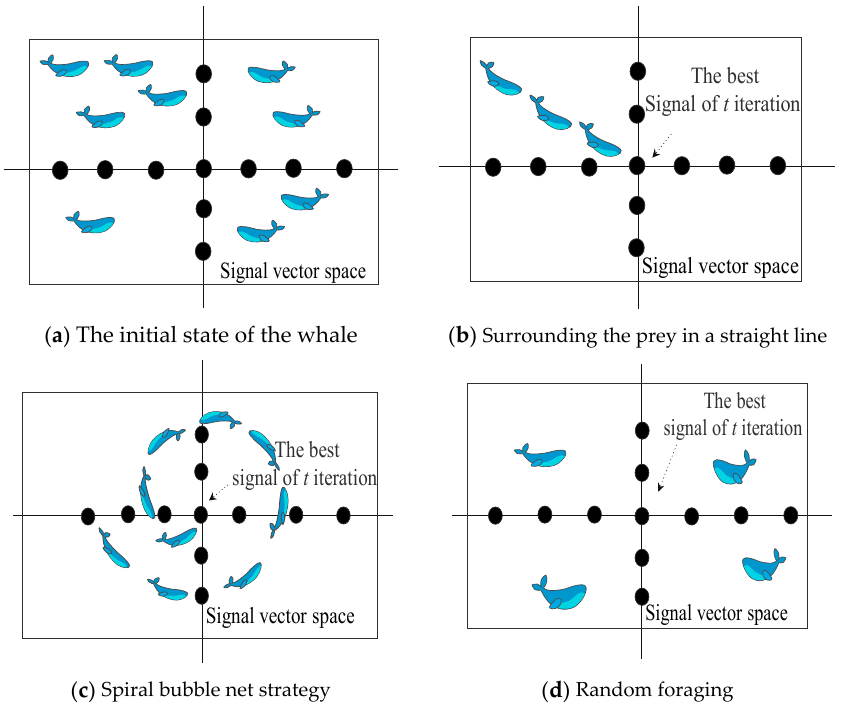
Figure 4. The whale optimization algorithm in MI-MIMO signal detection.